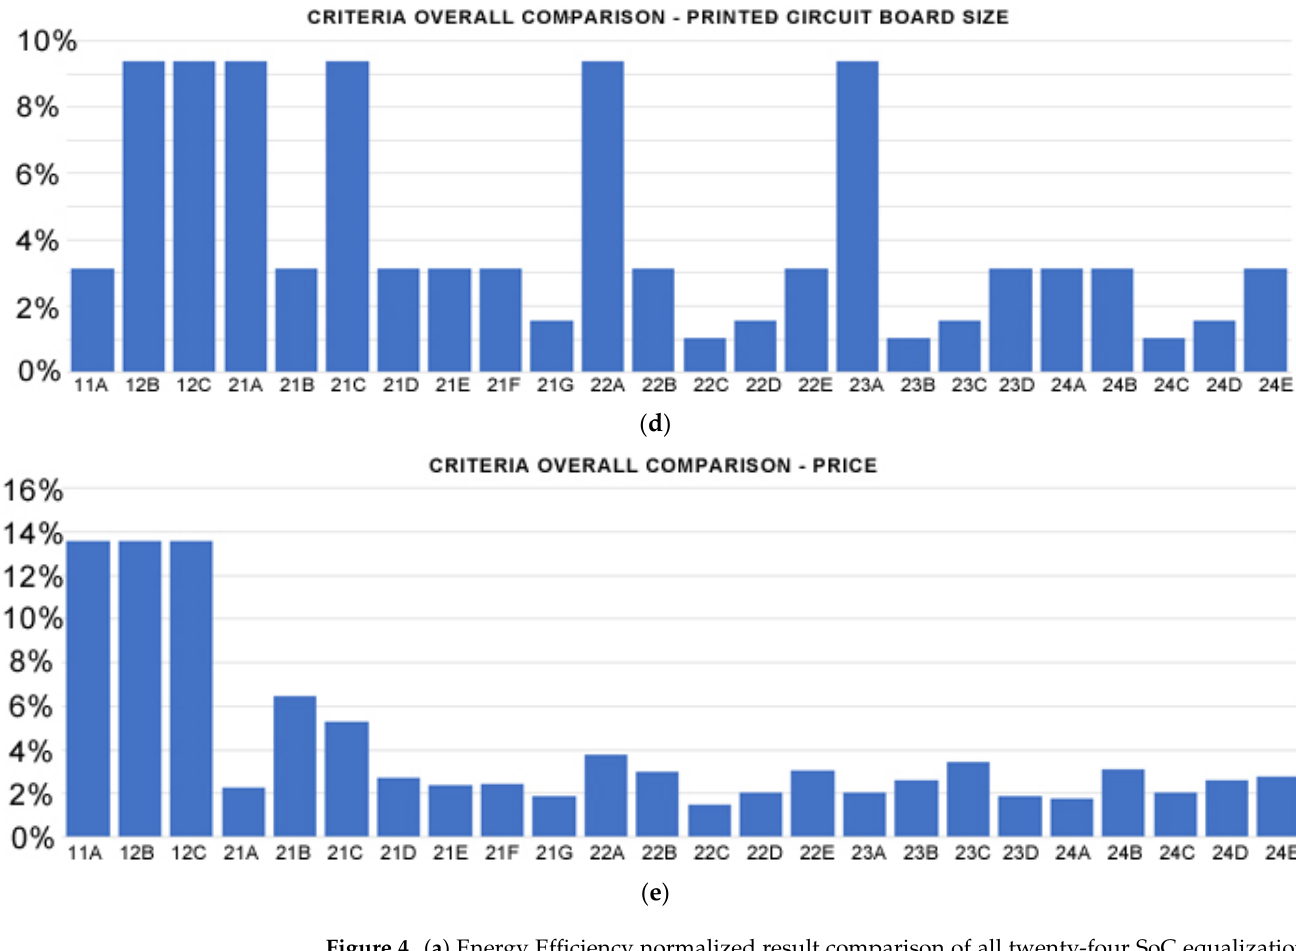
Table 10. Decision profile matrix ( δ ).